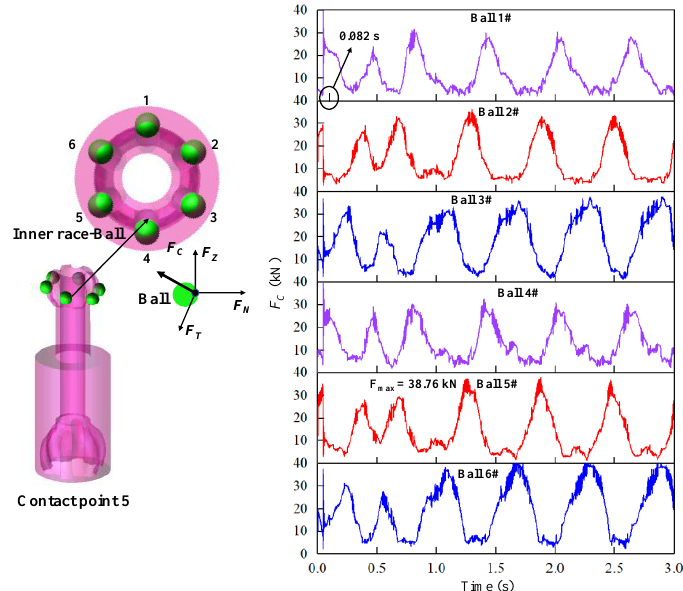
Figure 12. The variation of contact force between inner race and ball keys.